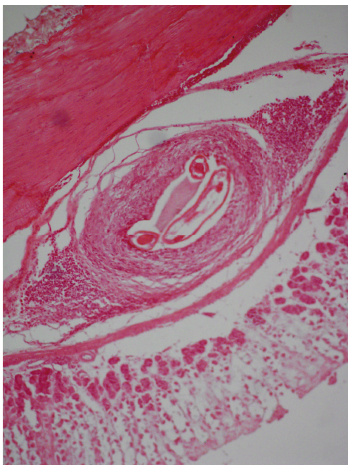
Figure 9: A section of chronically-infected aorta with S. lupi in the intimal region showing parasite remnants in dystrophic calcification surrounded by fibroblastic reaction within tunica intima (H. E. original magnification ×